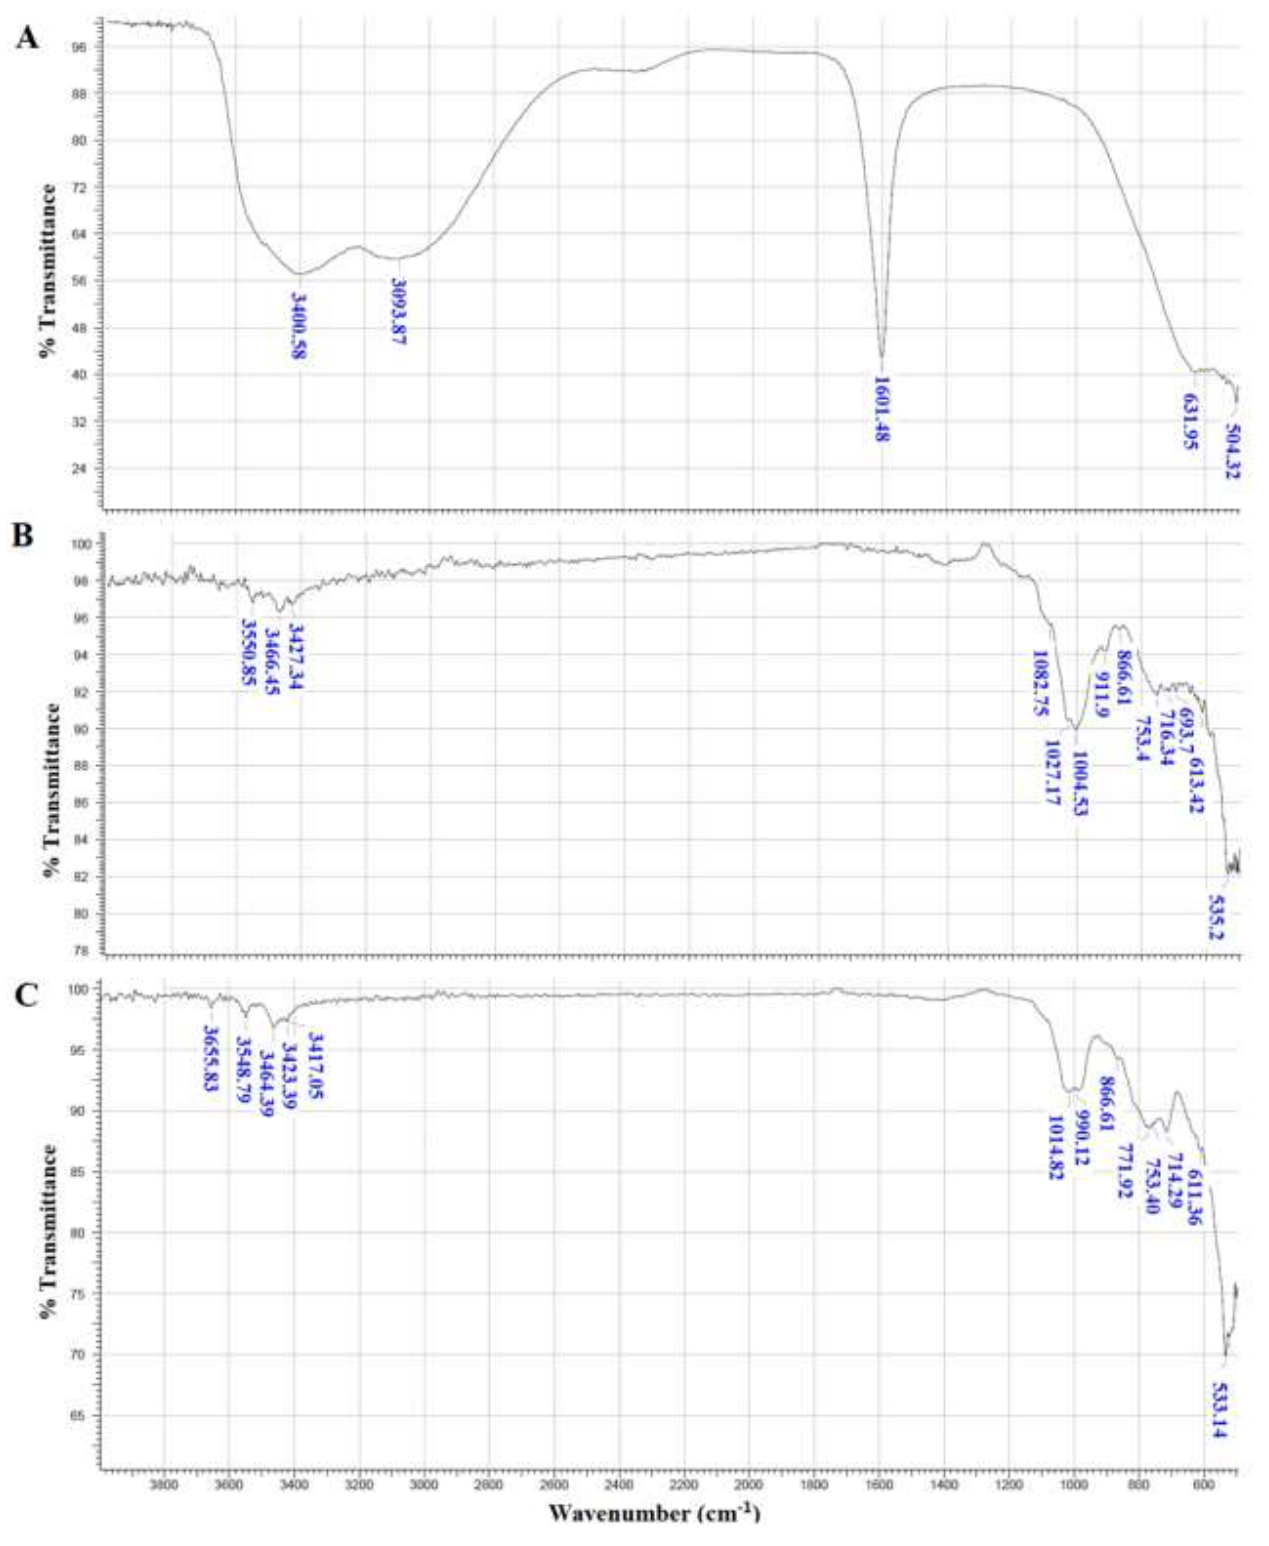
Figure 4. FTIR/ATR spectra in the range of 550 to 3900 cm − 1 of the dry samples used in the coagulation/flocculation process. ( A ) Ferric chloride (FeCl 3 ), ( B ) Flocs formed using the biocoagulant and ( C ) Flocs formed using the inorganic coagulant.